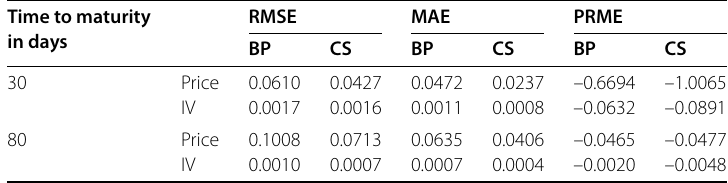
Table 2 Number of constraints, number of iterations, and the average computational time taken by the optimization routine of the proposed Bernstein polynomial method (BP) and the cubic spline smoothing method (CS) for times to maturity of 30 days and 80 days, respectively Time to maturity No. of constraints Iterations Average cpu time in days (n) (in seconds) 30 BP 21 12 0.0090 CS